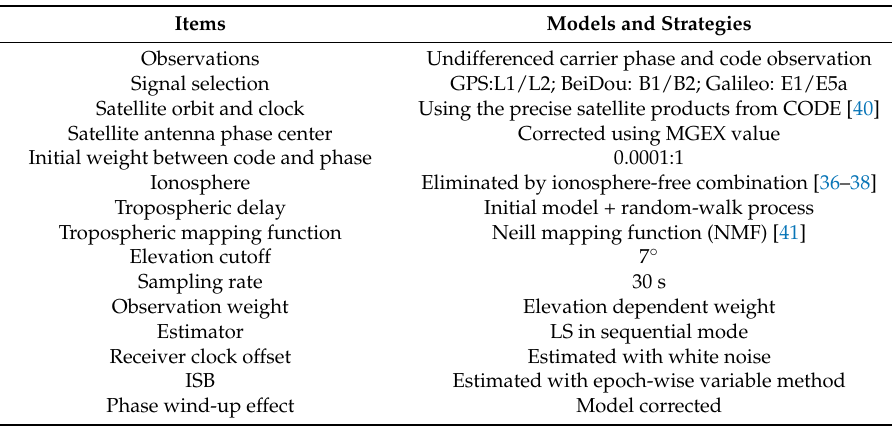
Table 3. Observation models and multi-system RINEX data processing